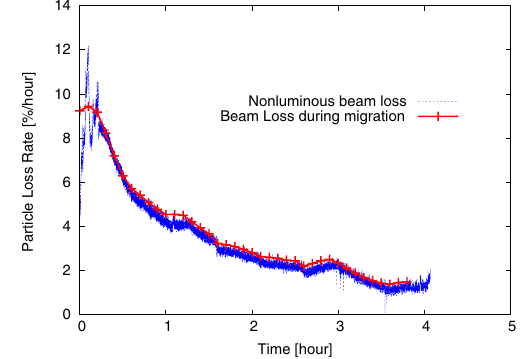
FIG. 5. Loss rate of particles leaking out of the central bucket but not getting into the satellite buckets (red) compared with the nonluminous beam loss rate (blue).